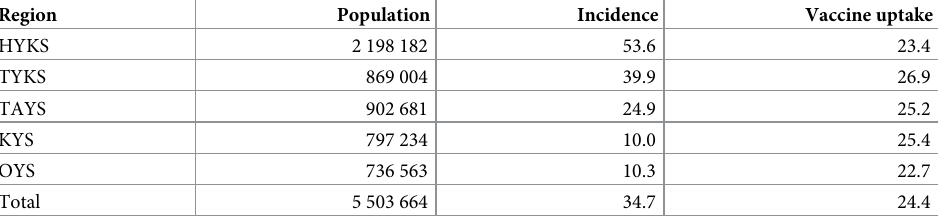
Table 3. Population, incidence (7-day case notification rate per 100 000 individuals), and vaccine uptake (propor- tion of vaccinated with first dose per 100 individuals) in five regions (university hospital specific catchment areas) of mainland Finland on 18 April